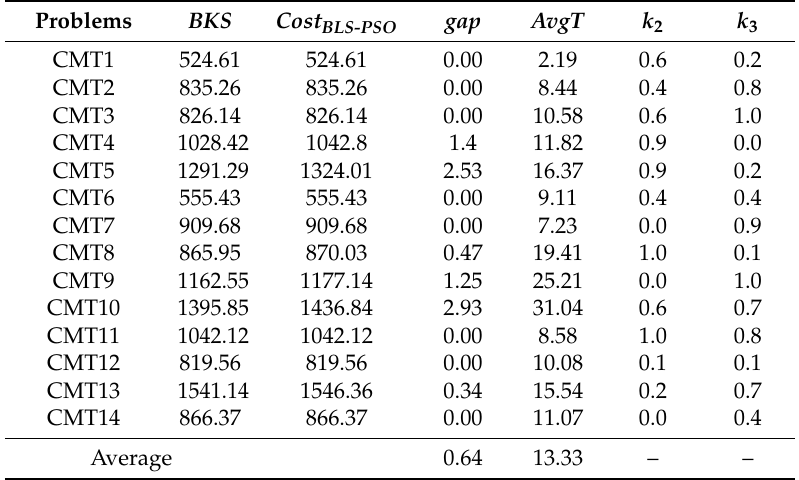
Table 10. Performance of BLS-PSO in solving the benchmark problems in Set